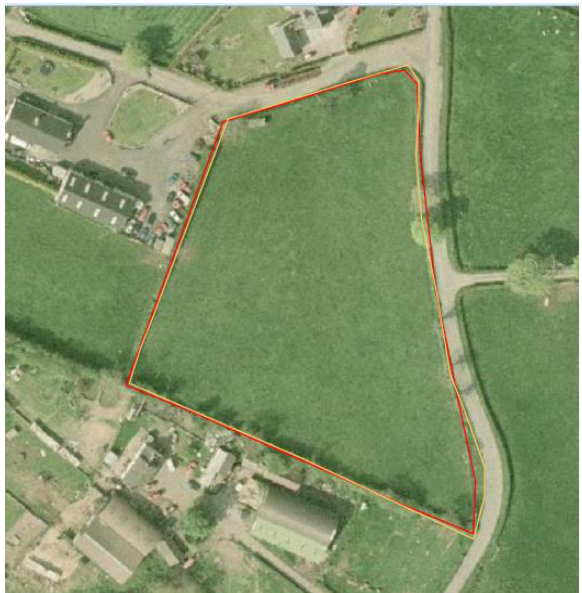
Figure 6: In this image in red the original boundaries of the reference parcel are shown. In yellow the boundaries of the parcel digitised by the operator.